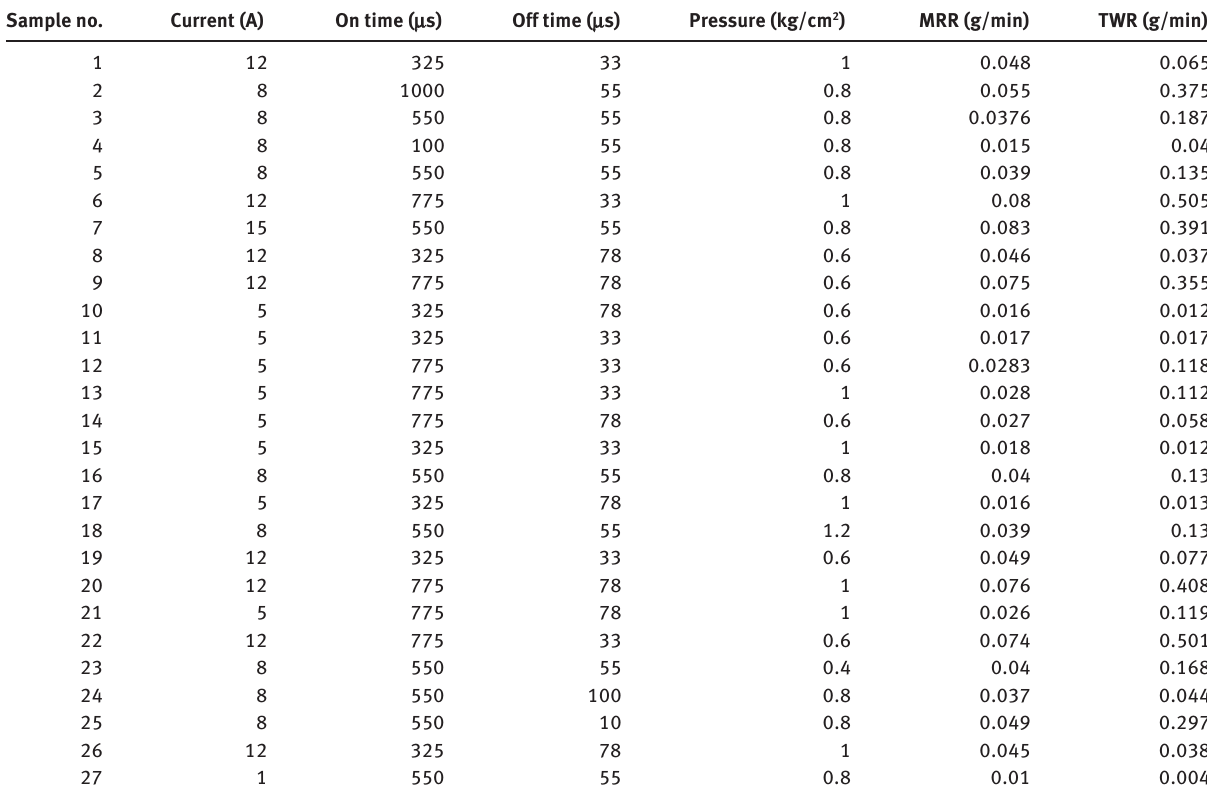
Table 2 Parametric investigations of MRR and TWR. Sample